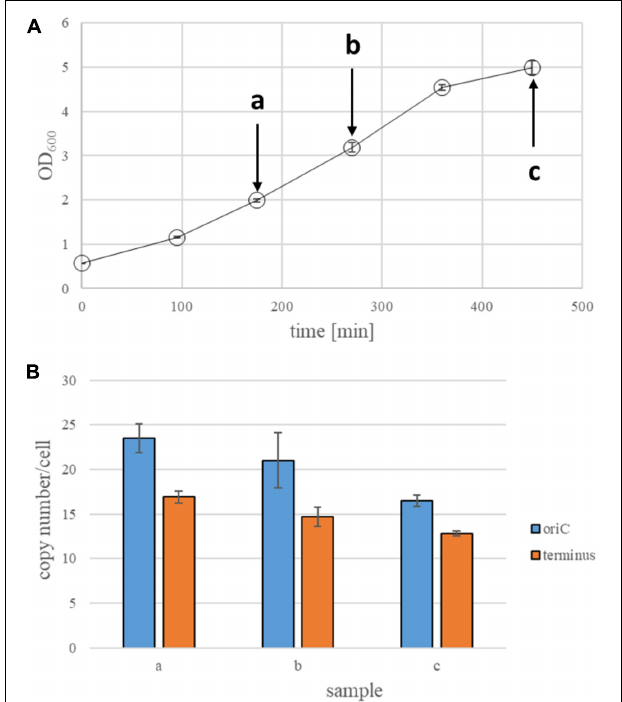
FIGURE 3 | Quantification of origin and terminus copy numbers in strain Zm6G under anaerobic conditions. (A) Growth curves of Zm6G strain under anaerobic conditions. Average OD 600 values of three biological replicates and their standard deviations are shown. Arrows indicate time points of collecting samples for quantification of genomic copy numbers. (B) Origin and termini copy numbers in anaerobically growing Zm6G. Samples at an early stationary phase were collected about 1 h after the culture reached a plateau of its growth curve. All time points at growth phase are three biological replicates, while two biological replicates at an early stationary phase and 5 biological replicates were made for a late stationary phase. Standard deviations (STD) are presented as error